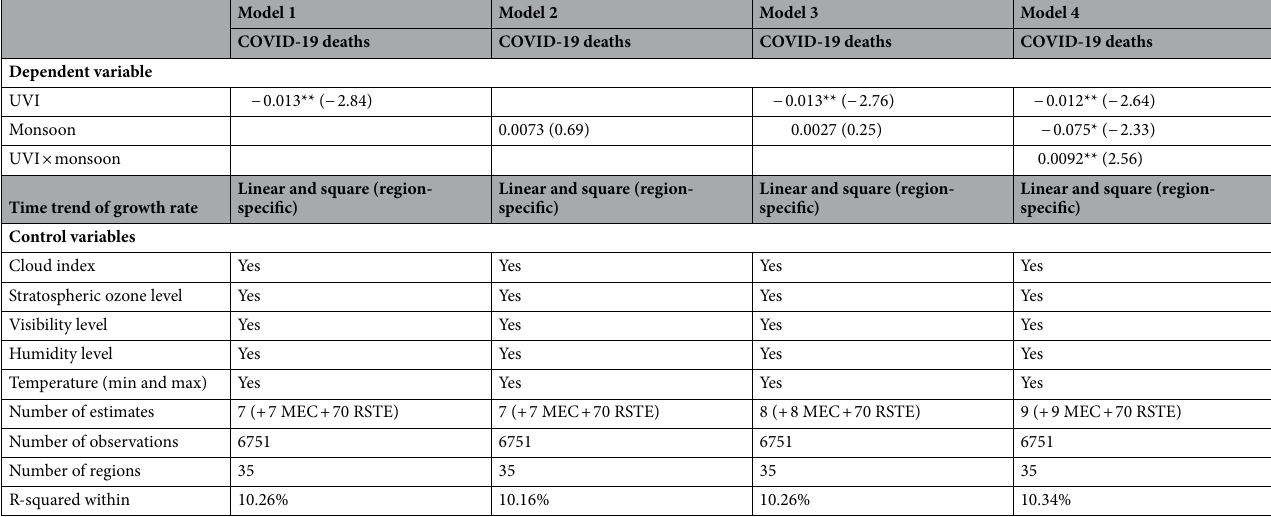
Table 3. Effect of the monsoon season, ultraviolet index (UVI) and their interaction on the cumulative COVID-19 deaths. t-statistics that tests the statistical significance (two-sided t-test) of the estimated associations between the dependent variable and the respective independent variable are in parentheses. MEC represents Mundlak error correction estimates which isolate the weather variables from region-specific time-